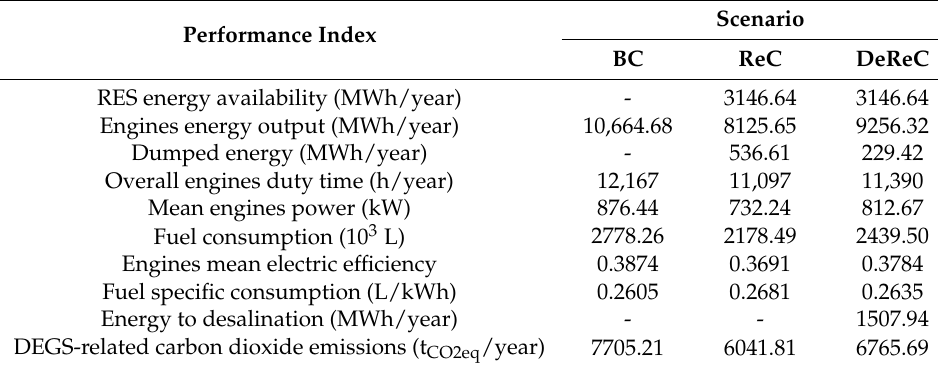
Table 3. Overall performance